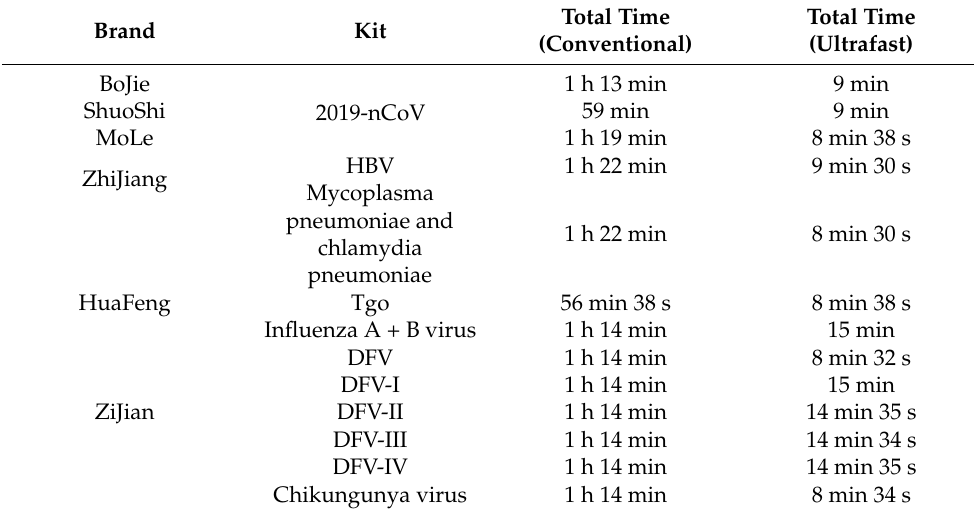
Table 1. Accelerating effect of PCR detection